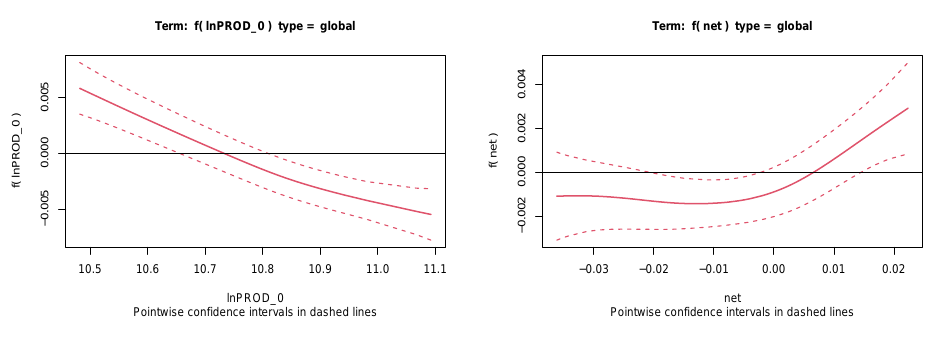
Figure 3: Ouput from codebox 15